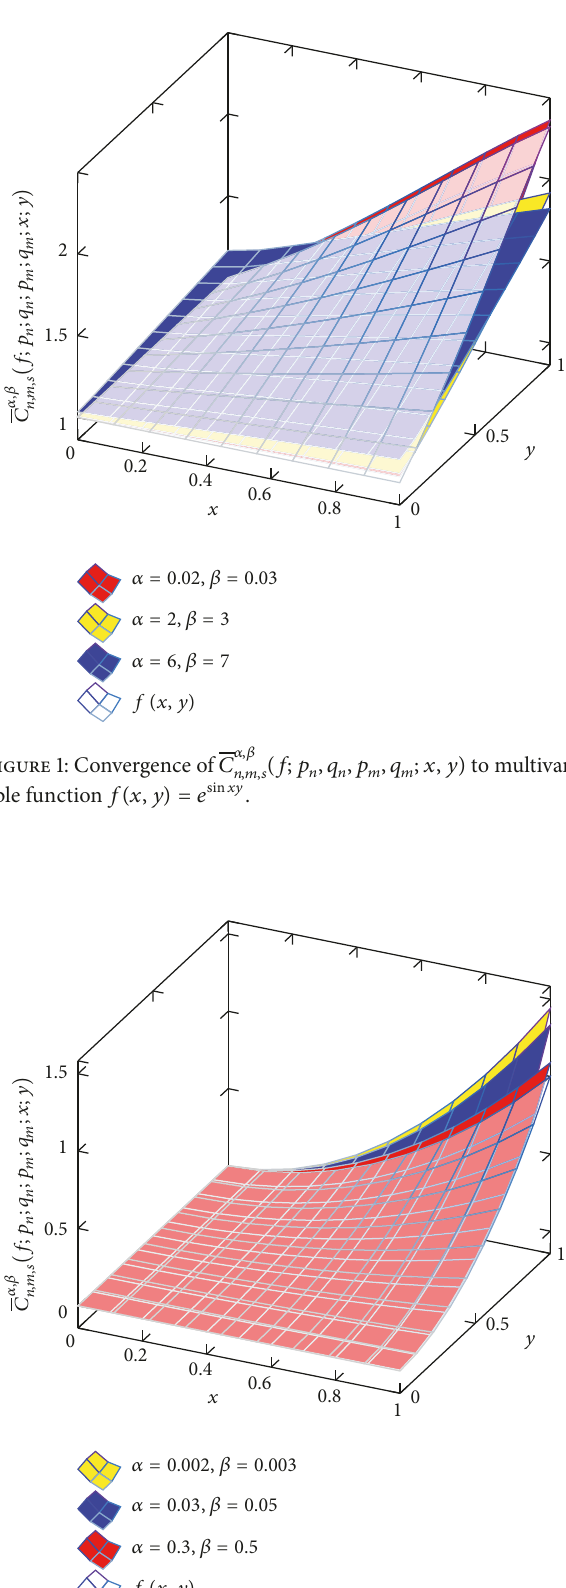
Figure 2: Convergence of 𝐶 able function 𝑓(𝑥,𝑦) = 𝑥 2 𝑦 2